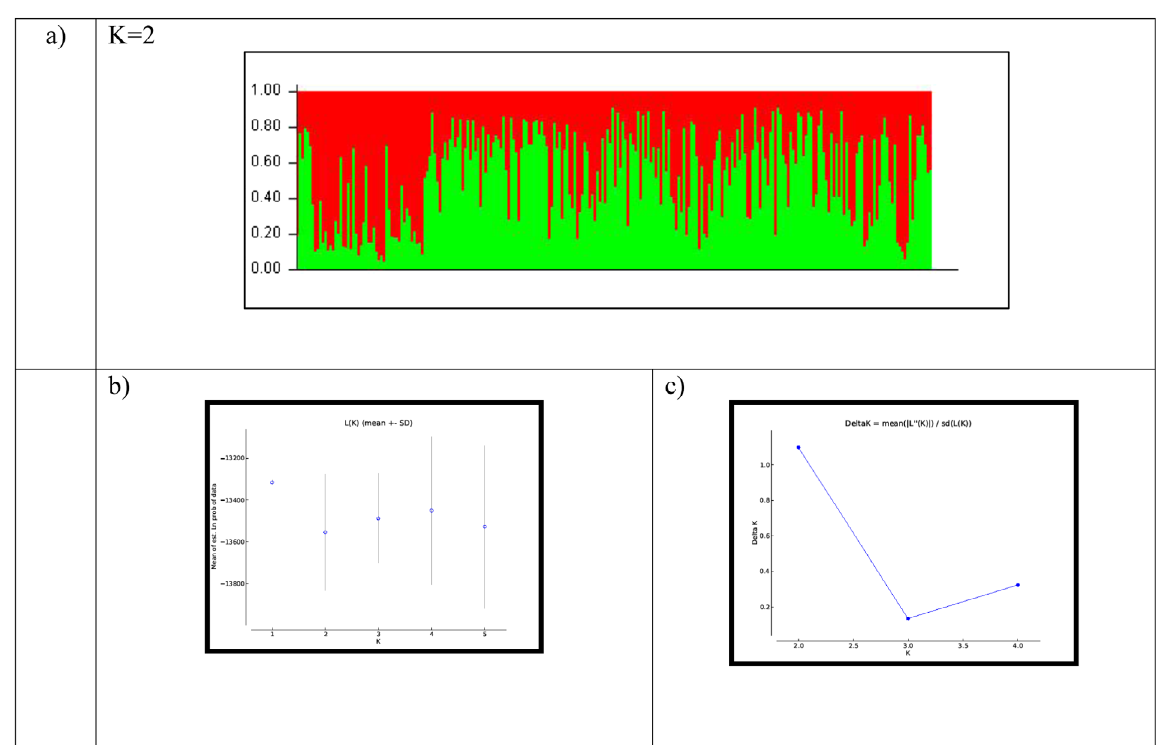
Fig. 2. Bayesian clustering of S. commerson individuals from STRUCTURE analysis. (a) Barplots for K = 2. Each individual is represented by a vertical bar partitioned into coloured sub-bars whose lengths are proportional to its estimated probability of membership for the K clusters. (b) Plot of the mean of estimated “ log probability of data ” for each value of K. (c) Delta K of Evanno's method based on the rate of change in the log probability of data.